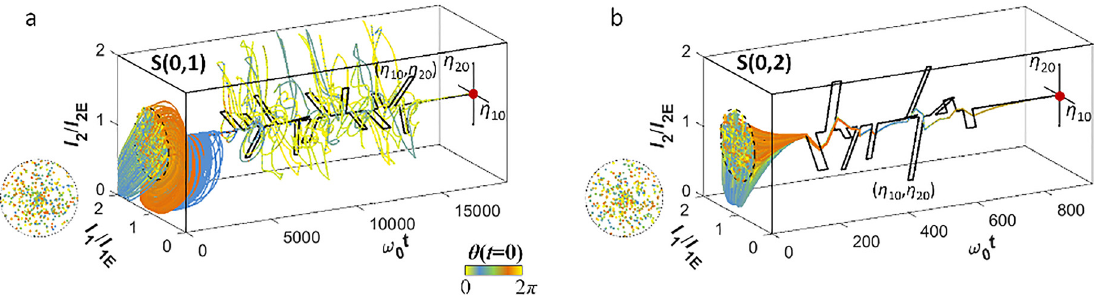
Figure 3: Topological protection against system perturbations in the temporal domain. (aandb)Trajectoriesof( I 1 , I 2 )forthe(a)S(0,1)phasearound( η 10 / κ , η 20 / κ )=(1.0, − 0.5)and(b)S(0,2)phasearound( η 10 / κ , η 20 / κ )=(2.0, −